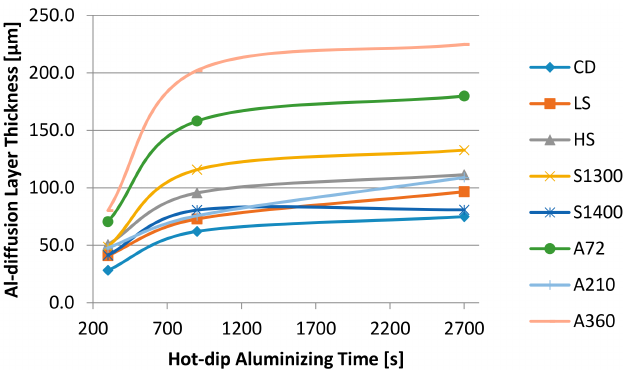
Figure 6. Ferrite-rich surficial layers thickness given by the aluminum diffusion within the tested